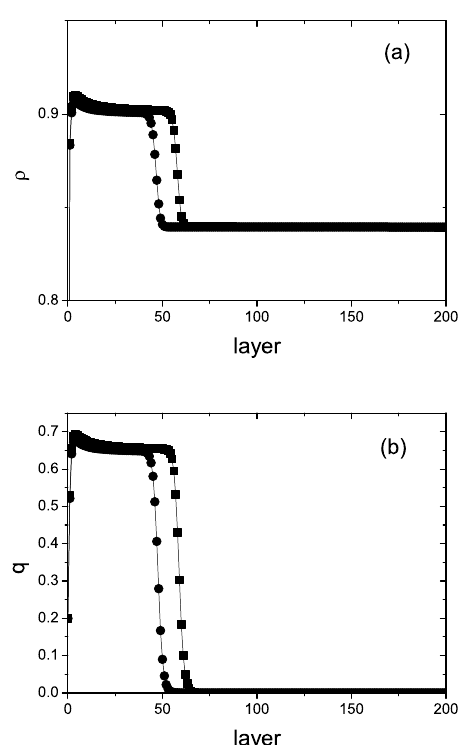
Figure 9. CS case. Profiles for: ( a ) occupancy and ( b ) orientational order parameter. Circles: (cid:101) (cid:96) ∼ (cid:96) − 1 ; squares: (cid:101) (cid:96) ∼ (cid:96) − 0.7 . θ s = 1.69, θ b = 1.80 and a = 1.0. Lines are just guides to the eye.